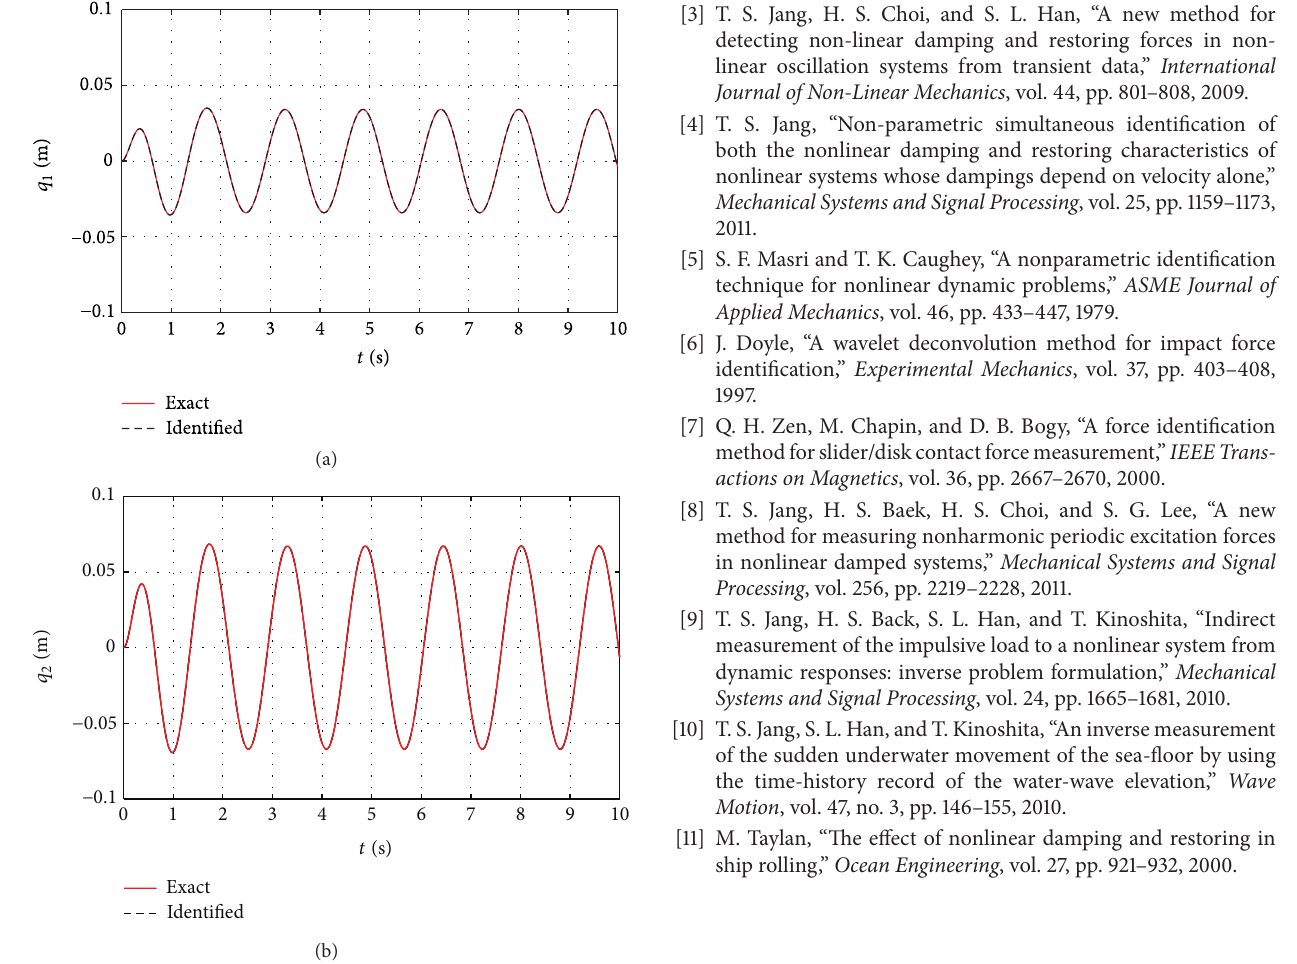
Figure 6: The recovered (or identified) responses compared with the exact